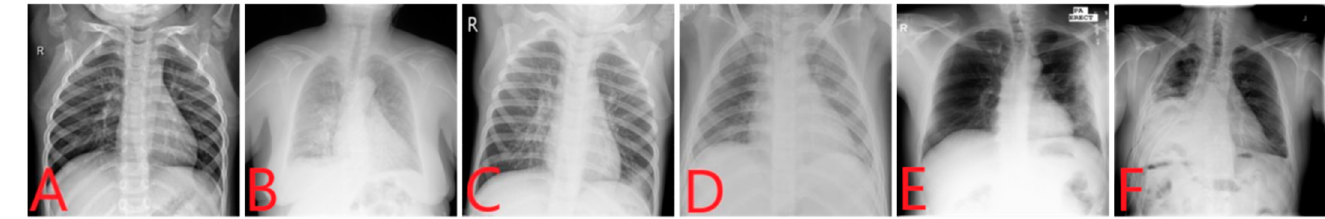
Figure 1. Sample images of different diseases: ( A ) Normal, ( B ) COVID-19, ( C ) Viral pneumonia, ( D ) Bacterial pneumonia, ( E ) Tb, and ( F ) Pneumothorax. Table 2. Combined balanced datasets for three and five diseases: Dataset-1 and Dataset-2, respec- tively.